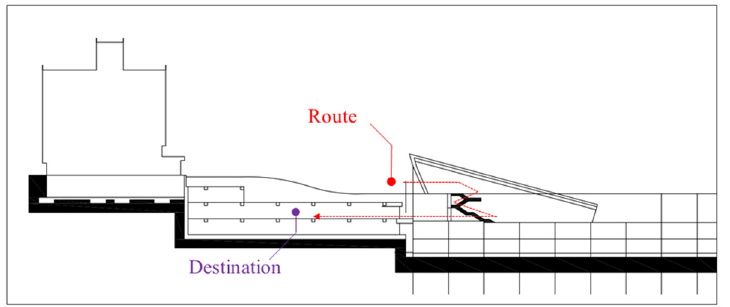
Figure 9. Scanning path of Case 1 (Campus building A).